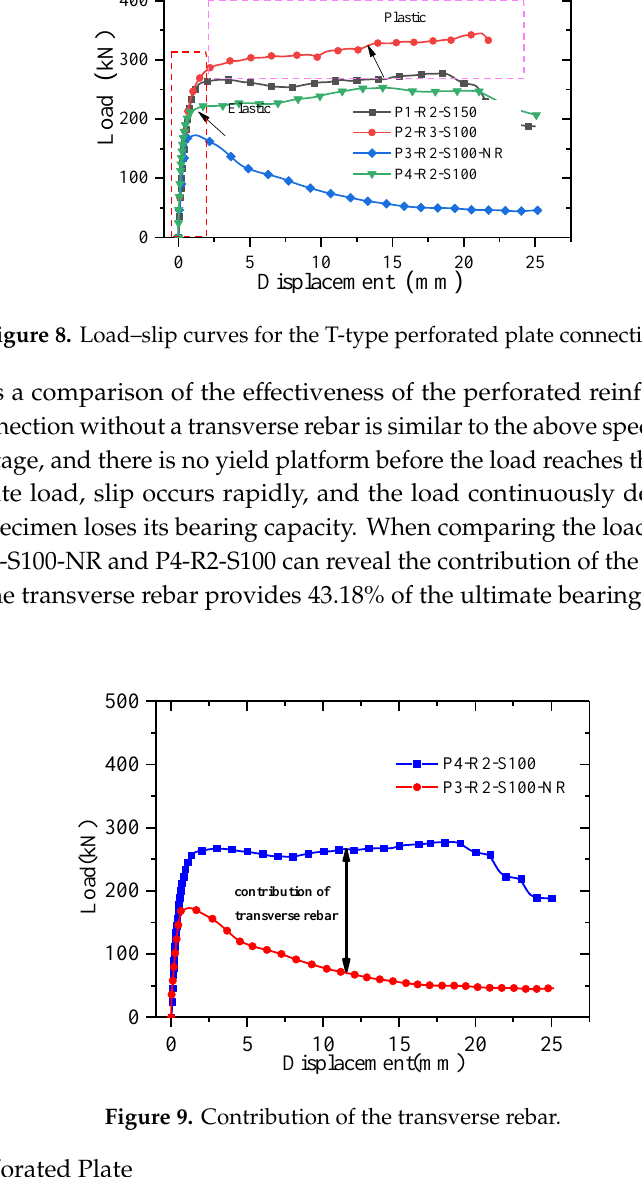
Figure 9. Contribution of the transverse rebar.